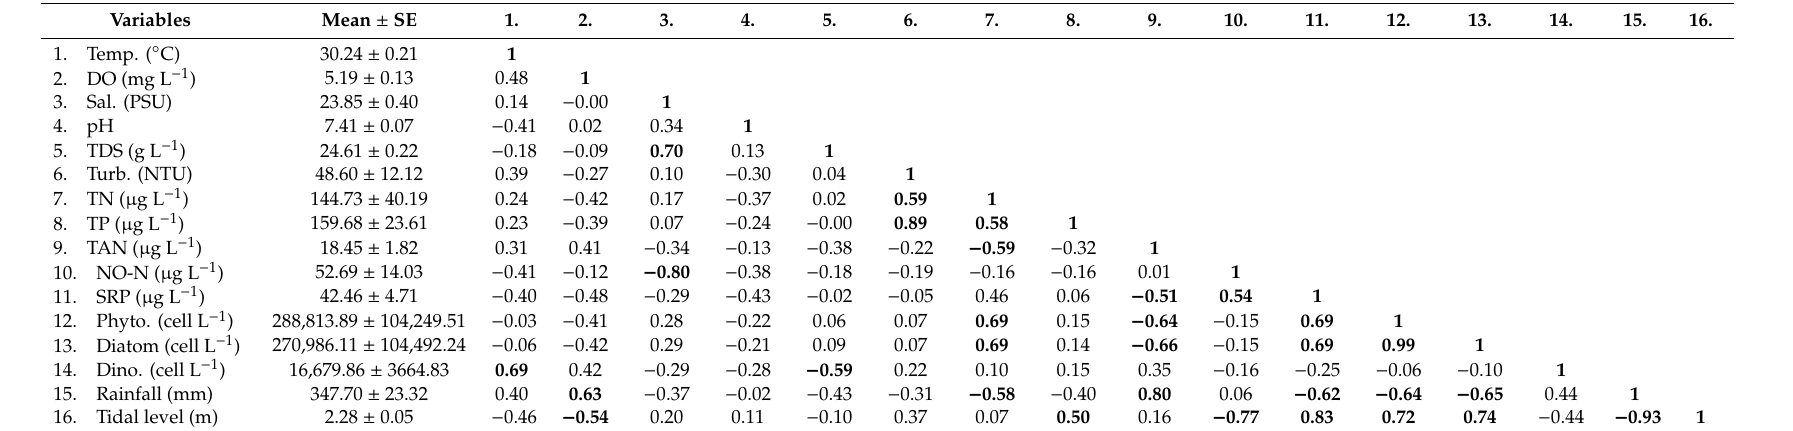
Table 1. Mean ± standard error (mean ± SE) and covariance correlation (Pearson) of major parameters in the Matang